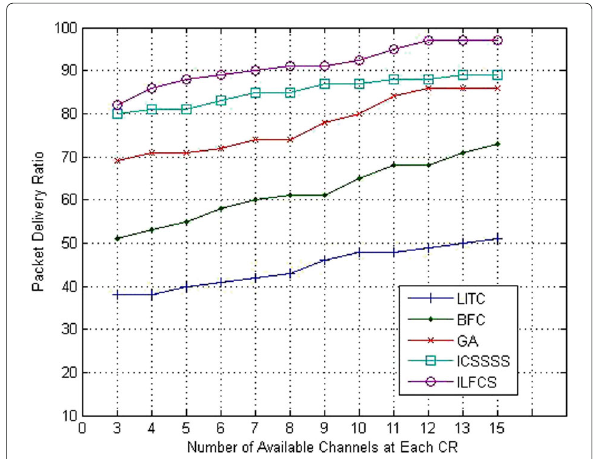
Fig. 16 End-to-end delay under different number of available channels. The results of different simulation experiments to measure End-to-end delay at different numbers of available channels for the BFC, LITC, GA, ICSSSS and the ILFCS are